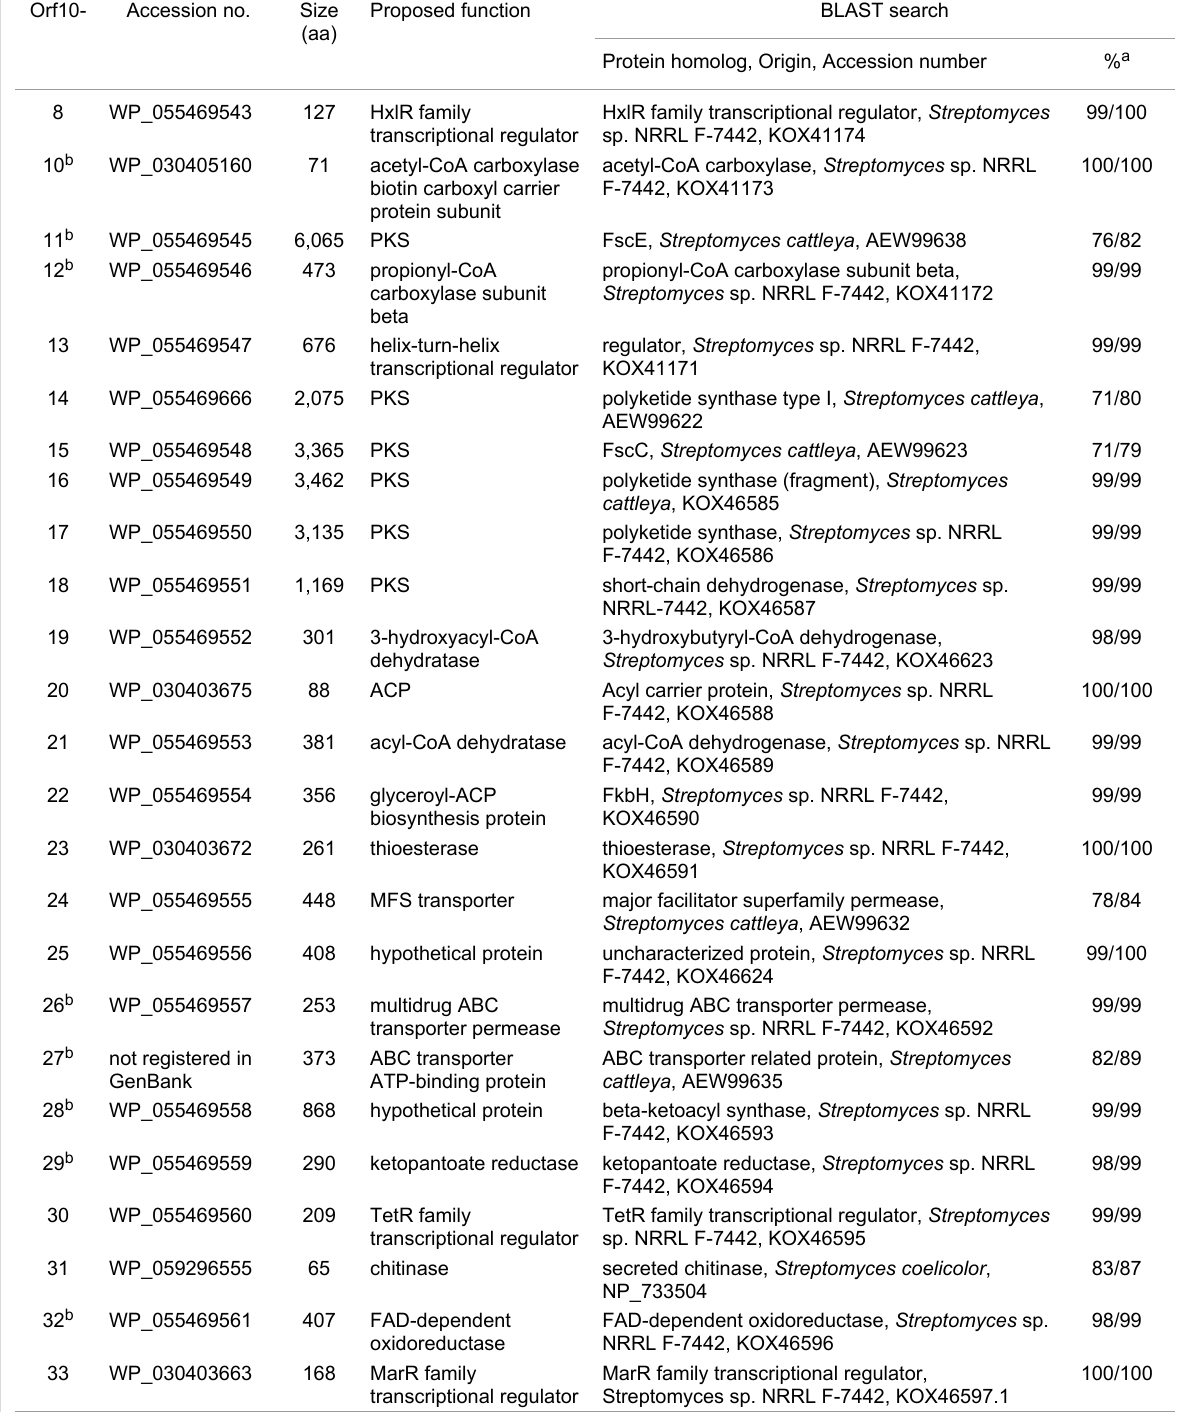
a Identity/similarity; b encoded in complementary